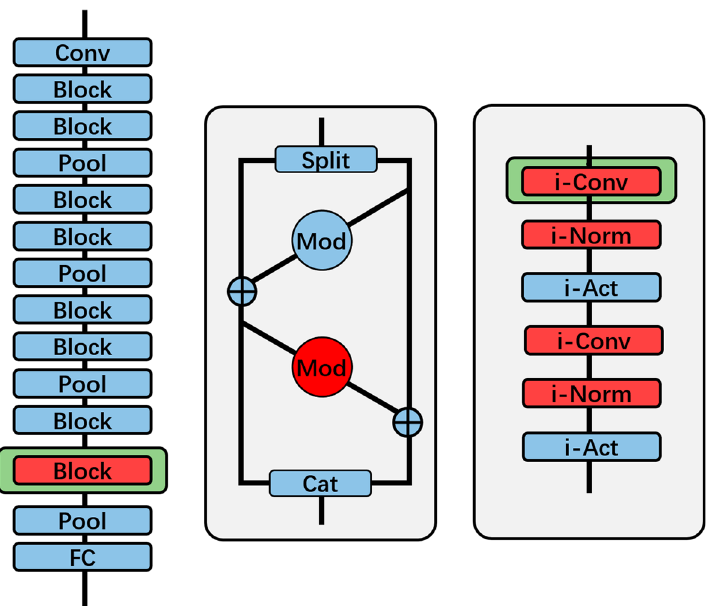
Fig. 8 Illustration of a hybrid architecture and its peak memory